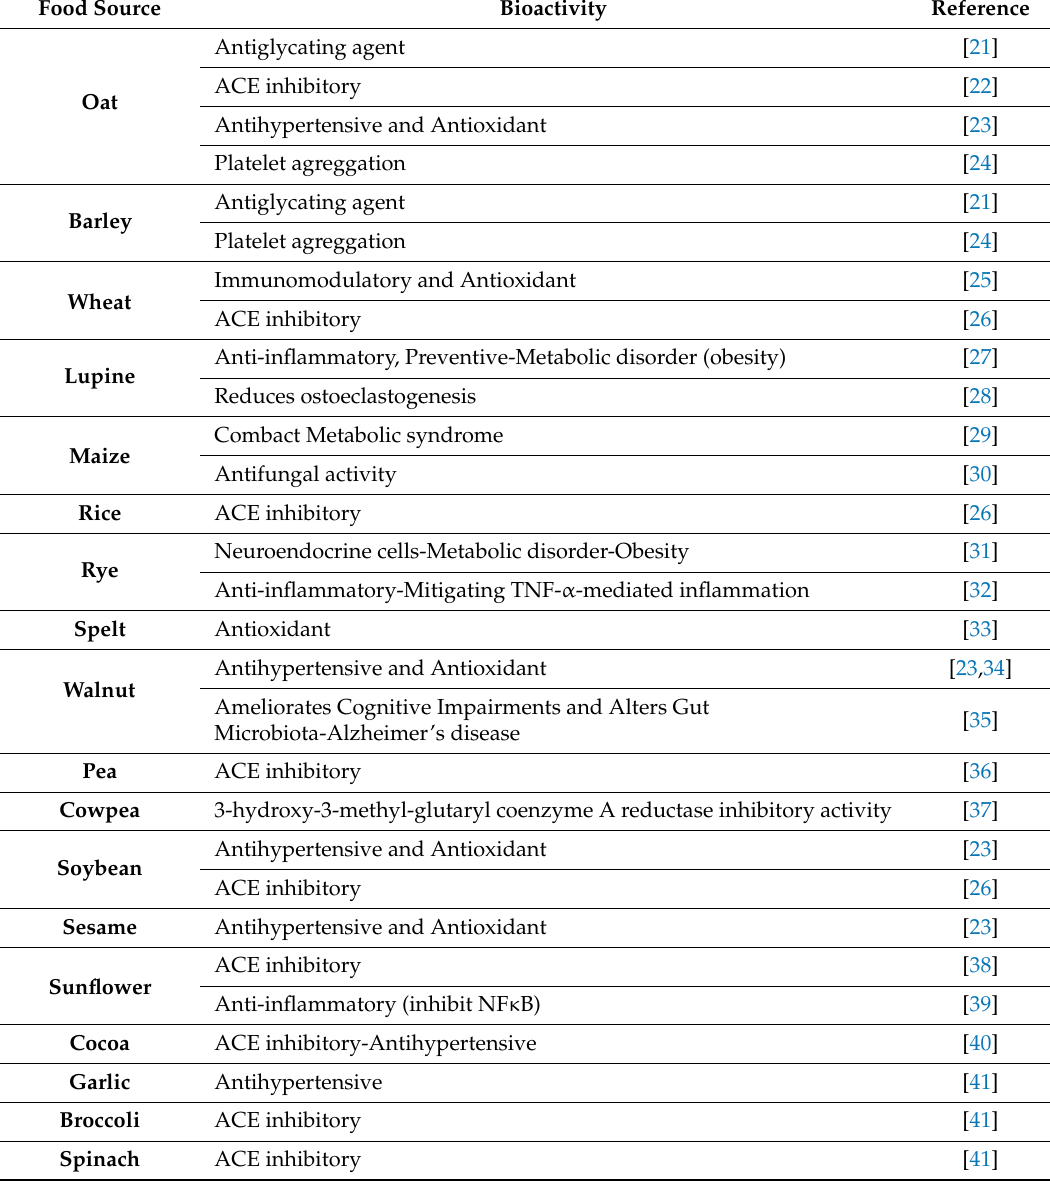
Table 1. Sources of bioactive peptides from the plant kingdom with the relative biological properties. Food